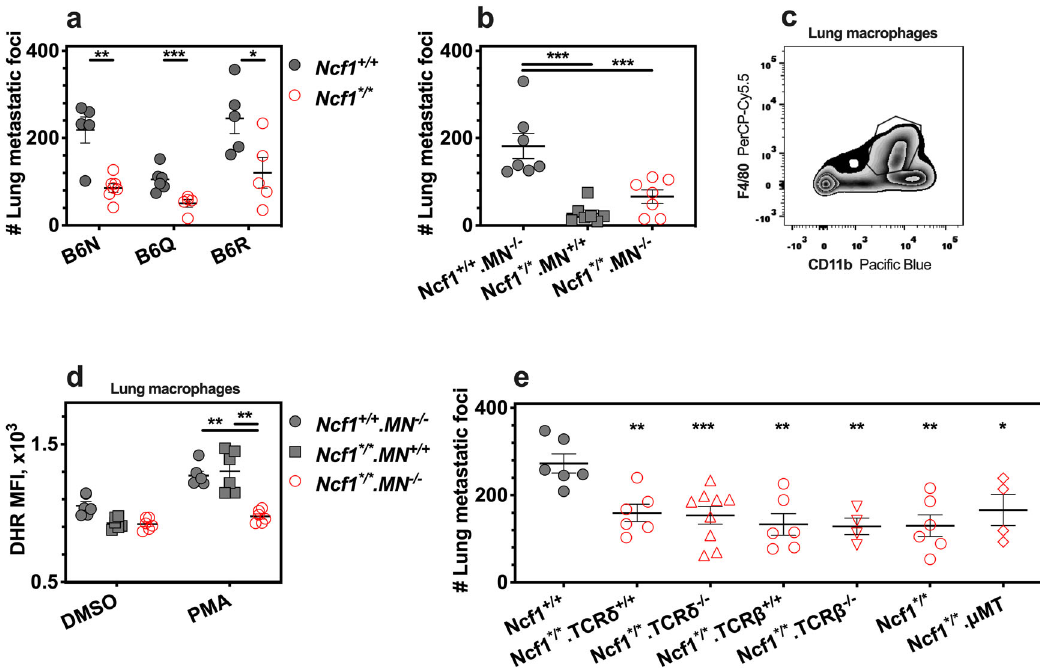
Fig. 1 Ncf1 mutation reduces lung colonies of B16F10 cells. The lungs were harvested from mice at day 10 after intravenous injection of B16F10 cells. a The number of tumor colonies in Ncf1 mutant mice ( Ncf1 */* ) and wild-type controls ( Ncf1 + / + ) of B6N.Ncf1 */* ( n = 7) versus B6N.Ncf1 + / + ( n = 5), B6Q.Ncf1 */* ( n = 5) versus B6Q.Ncf1 + / + ( n = 6), and B6R.Ncf1 */* ( n = 5) versus B6R.Ncf1 + / + ( n = 5). b The number of tumor colonies in wild-type mice ( Ncf1 + / + . MN − / − , n = 7), MN mice ( Ncf1 */* . MN + / + , n = 7), and Ncf1 mutant mice ( Ncf1 */* . MN − / − , n = 7). c A representative fl ow cytometry plot graph shows the gating of CD45 + CD11b + F4/80 + cells (macrophages), and d , ROS production by DHR staining in fl ow cytometry, after lung cells were incubated ex vivo with PMA and DMSO as the control (six mice per group). e The number of tumor colonies in mice of Ncf1 */* . TCR δ − / − ( n = 9) versus Ncf1 */* . TCR δ + / + ( n = 6), Ncf1 */* . TCR β − / − ( n = 4) versus Ncf1 */* . TCR β + / + ( n = 6), and Ncf1 */* ( n = 6) versus Ncf1 */* . μ MT ( n = 4), compared with that in wild-type mice ( n = 6). All results are shown as mean ± SEM. Mann – Whitney U test, * p < 0.05, ** p < 0.01, and *** p <